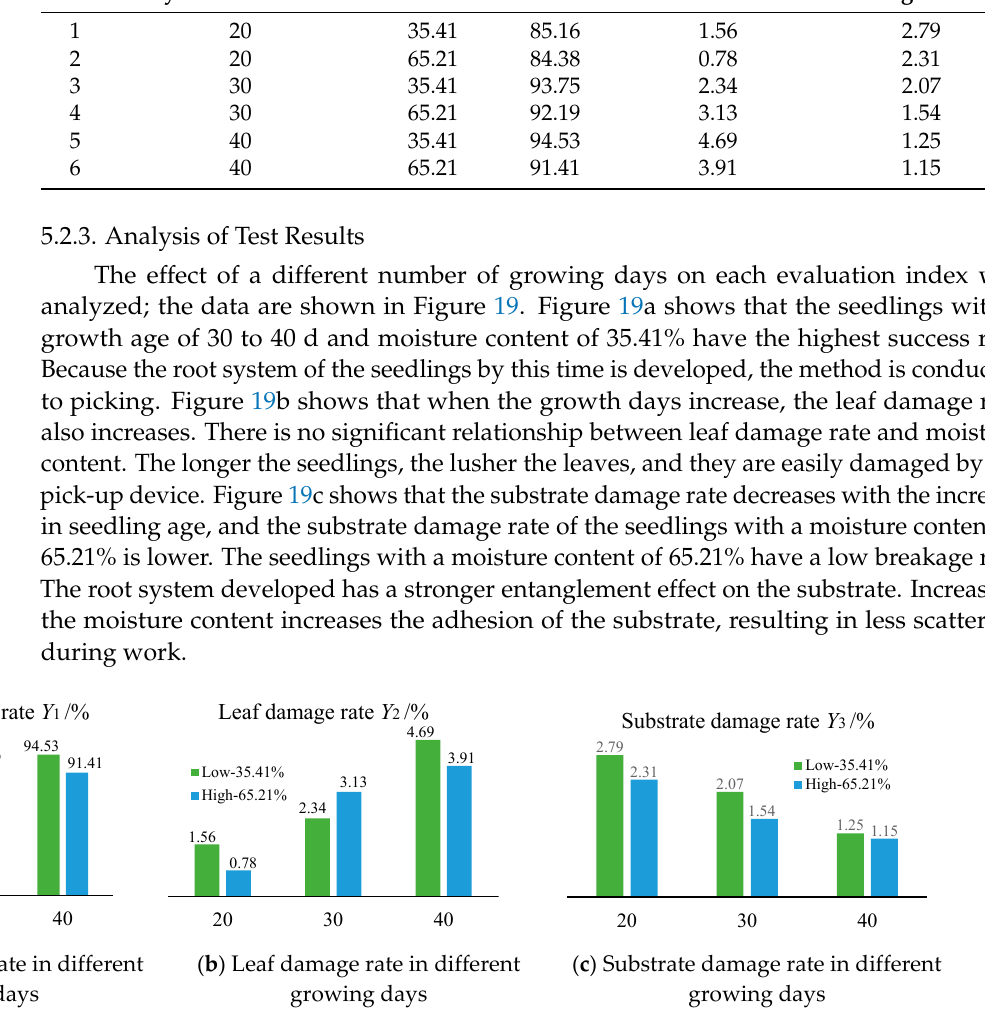
Figure 19. Results of seedling picking after 20, 30, and 40 growing days.